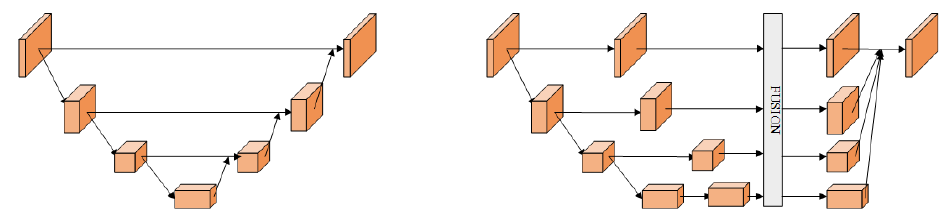
Figure 1. An example of high-resolution representation recovering ( left ) and an example of high- resolution representation maintaining ( right